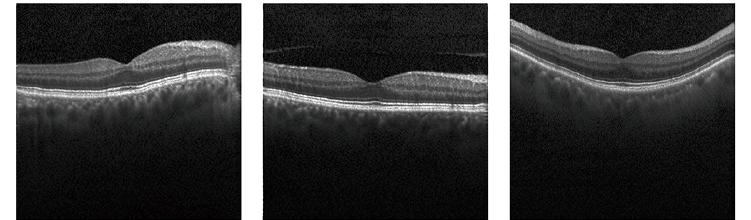
Figure 8. Few-shot learning results with only 100 normal images used as the training data. Although the sample data size for training is substantially reduced, our model is still able to generate clear and realistic retinal